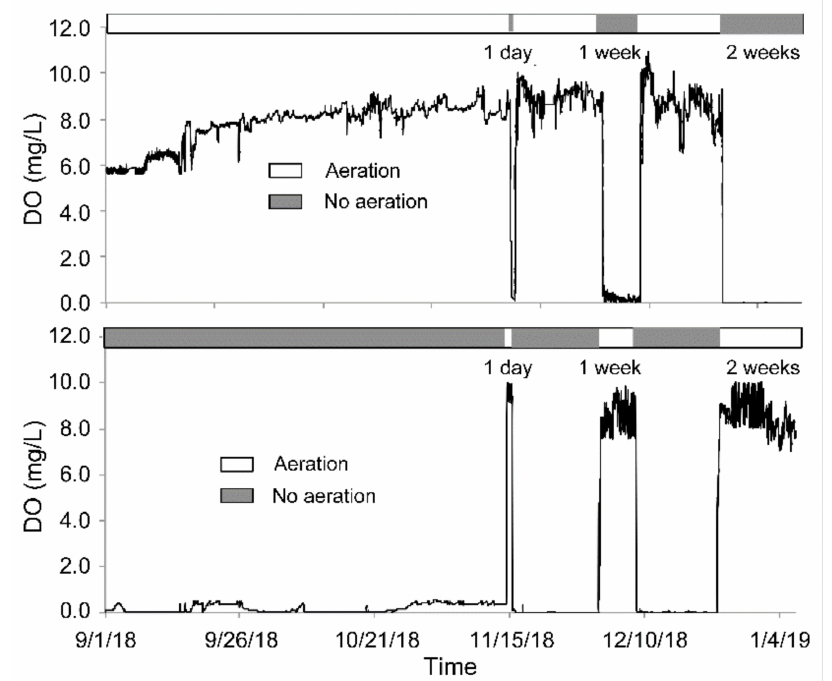
Figure 3. The measured dissolved oxygen concentration dynamics in the aerated reactors disturbed by short-term aeration interruption (AE-D) (above) and non-aerated reactors disturbed by short-term aeration (AN-D) (below)